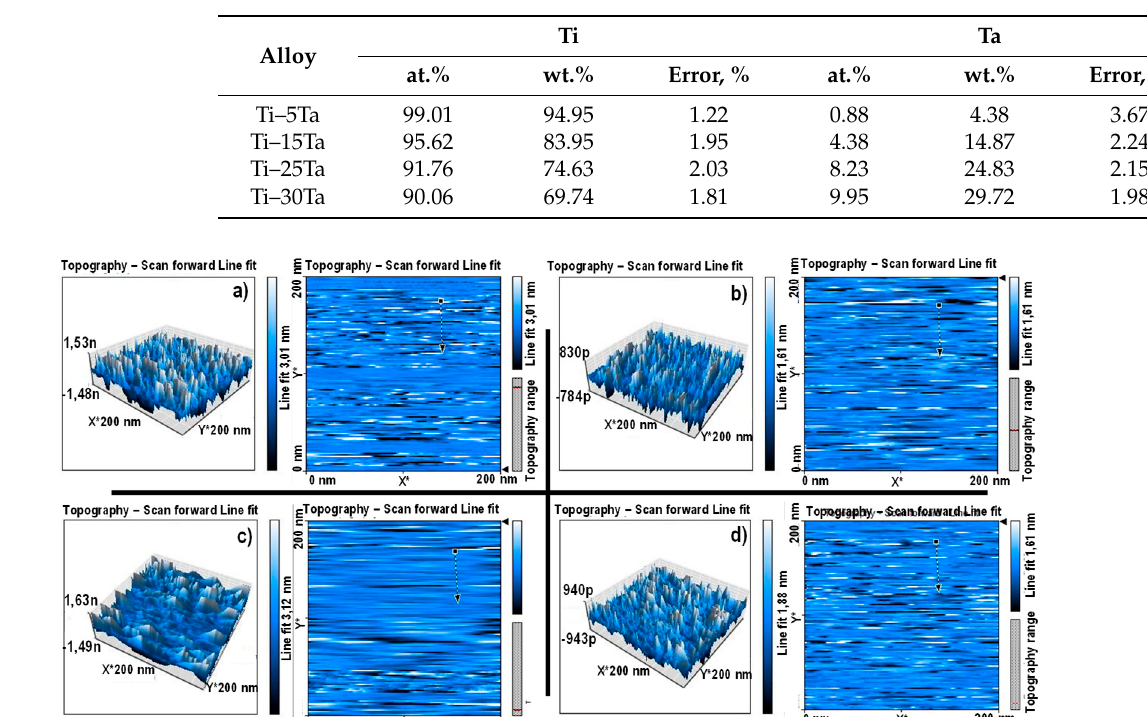
Table 3. EDS global analysis on micro-areas for Ti–xTa alloys.